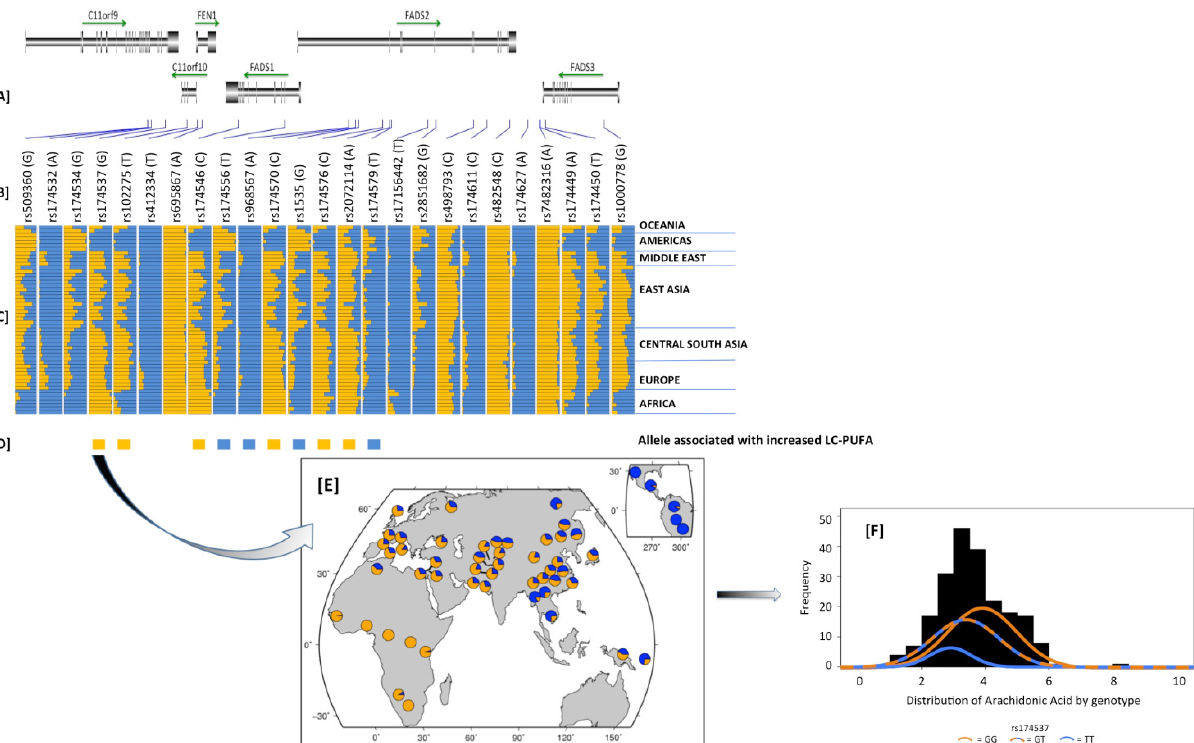
Figure 4. Dramatic differences in the frequency of derived alleles in a 100 kb region surrounding rs174537 in the Human Genome Diversity Panel Data. ( A ) is the physical location of the SNPs and genes in the region; ( B ) is SNP name and the specific derived allele in parenthesis; ( C ) is the derived allele frequency in orange in 52 populations clustered based on geography; ( D ) reflects the allele associated with increased LC-PUFA metabolism from published studies.; ( E ) is the detailed overview of rs174537; ( F ) shows three distributions within the Tangier Island Population. Adapted from Mathias et al. [149] (Panels A – E ) and from Mathias et al [111] . (Panel F